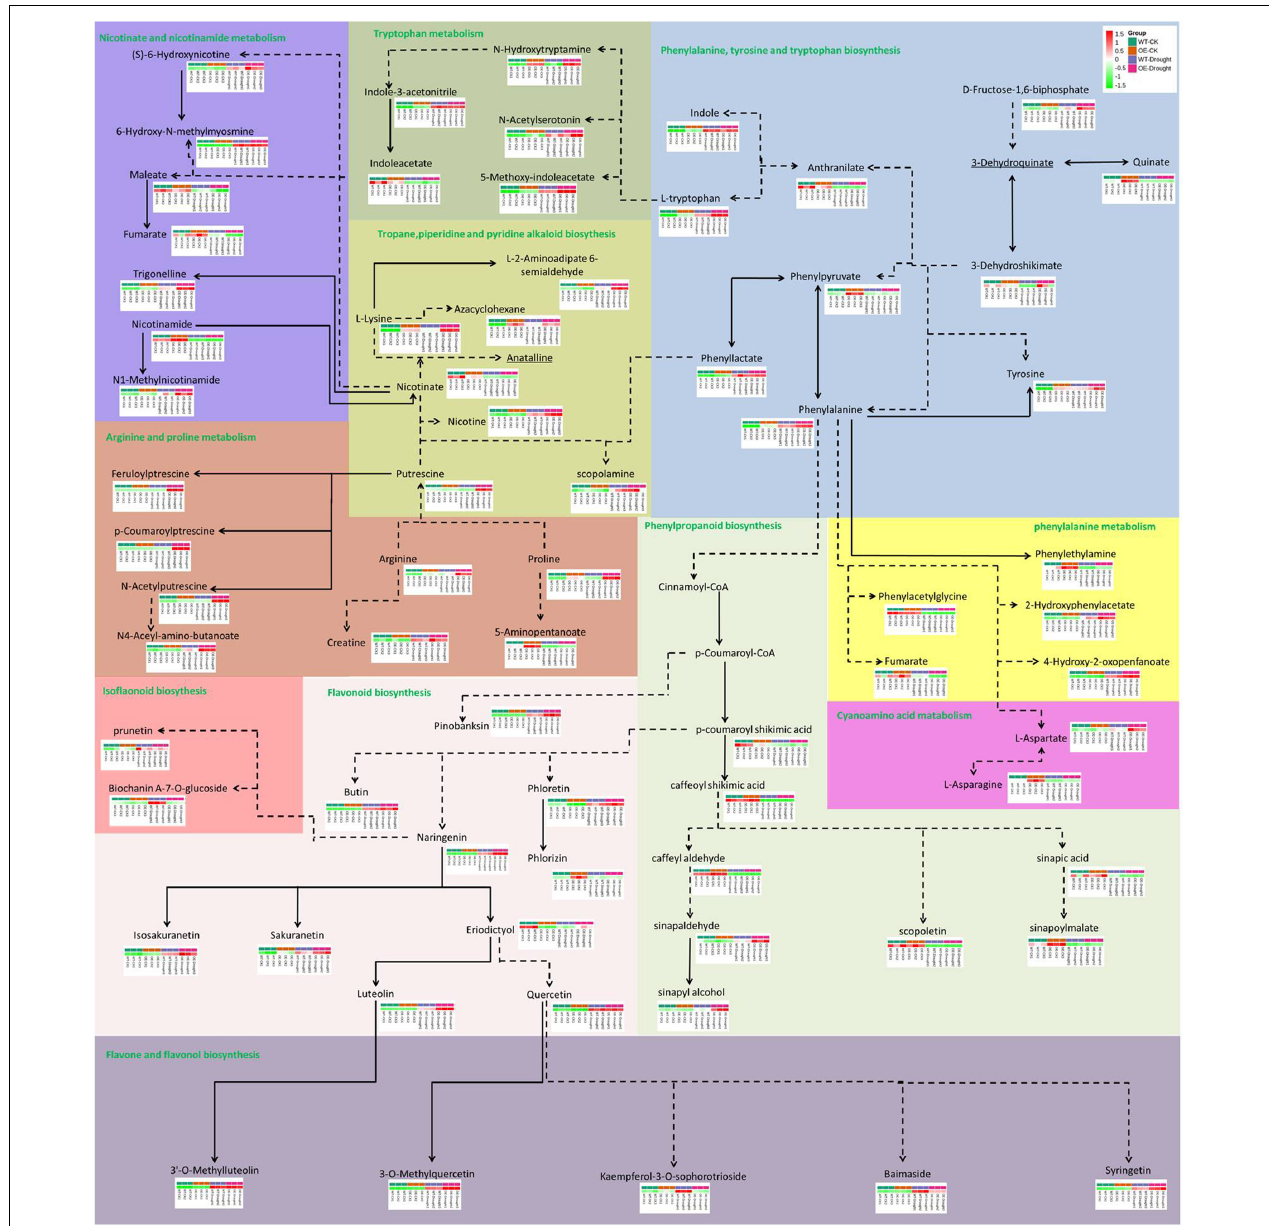
FIGURE 10 | Analysis of pathway metabolite changes between WT and OE plants under normal and drought treatments. Dashed arrows represent multiple enzymatic steps. Red represents upregulated metabolites, while green represents downregulated metabolites.